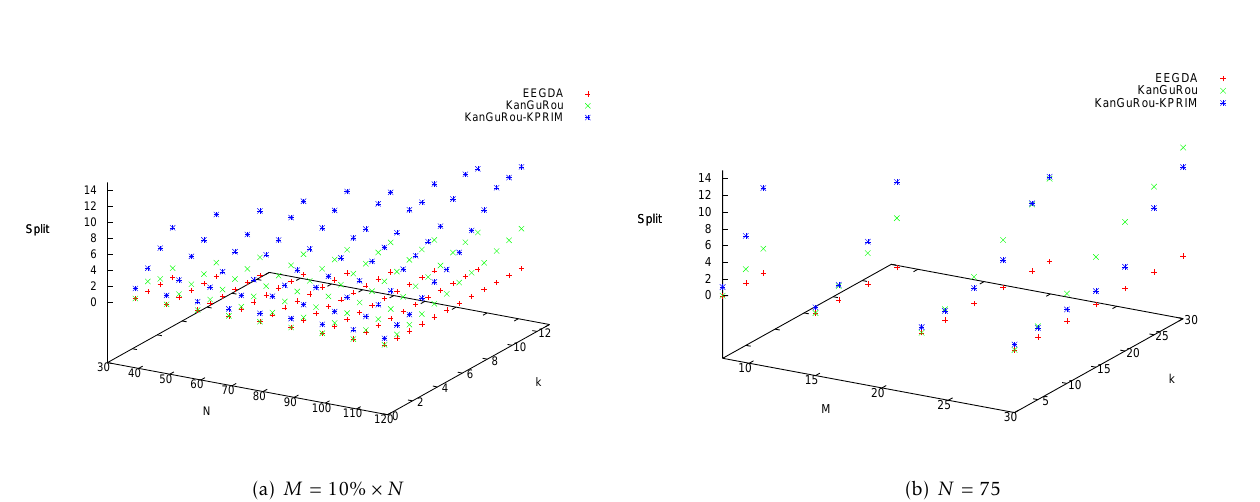
Figure 4. Number of splits for each algorithm. M = number of